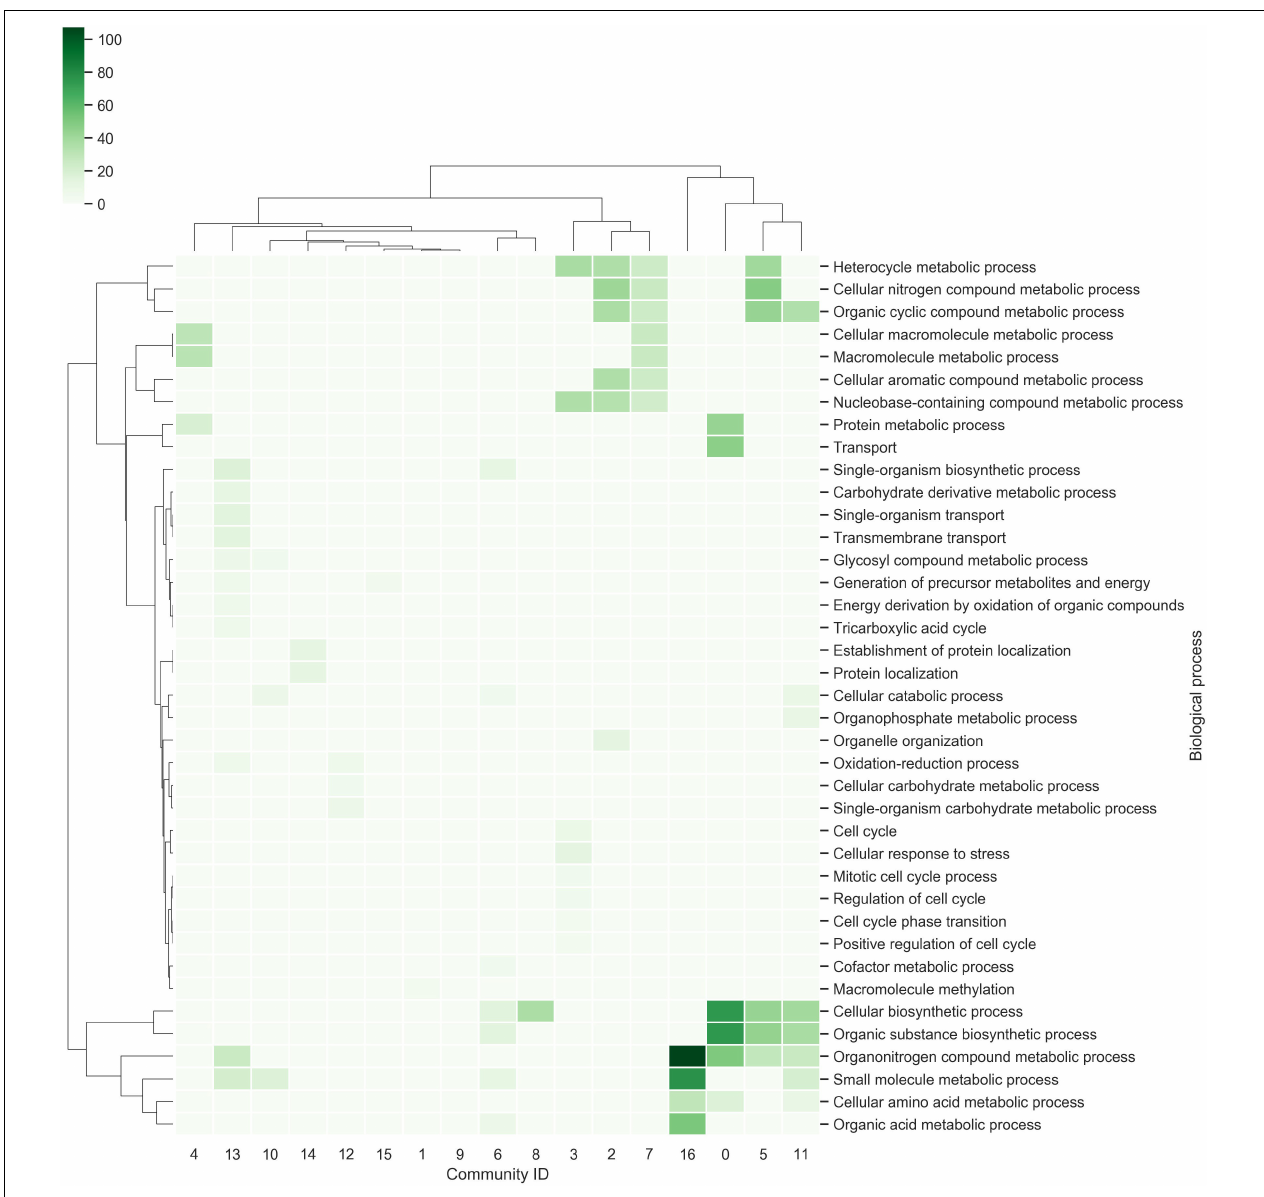
FIGURE 3 | Communities in the network. The richest biological processes for each community were identified and hierarchically clustered based on Euclidean distance measures and Ward’s method for linkage analysis. Each row represents the GO term for biological processes, and each column represents the community